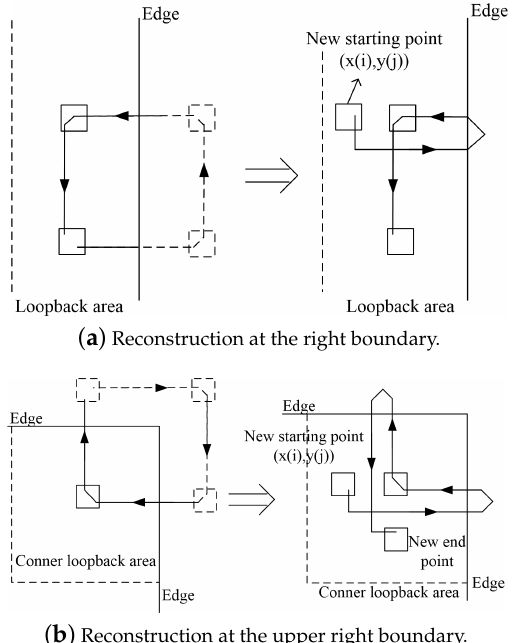
( b ) Reconstruction at the upper right boundary. Figure 13. Reconstruction of the partial-cascade structure in the loop-back